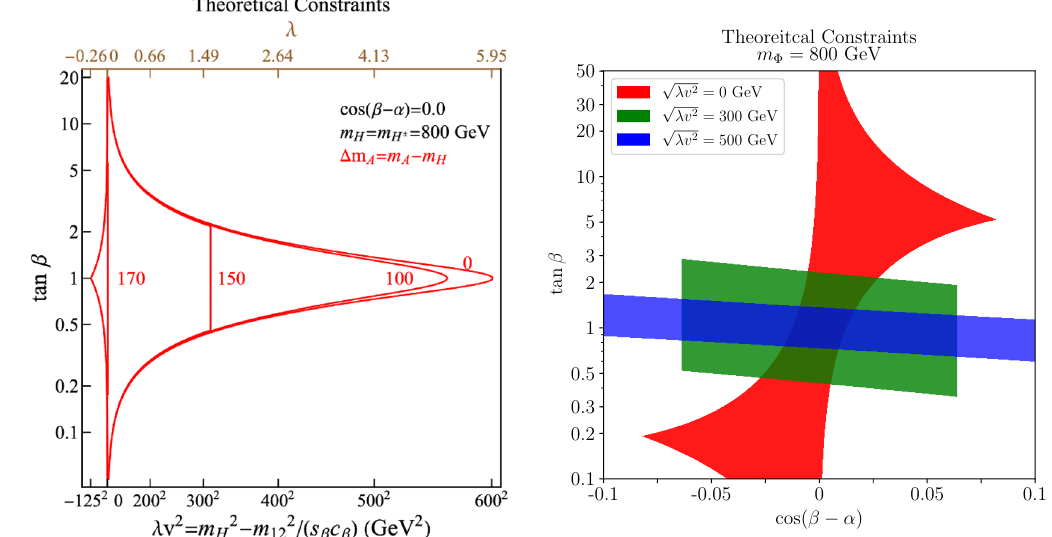
Figure 1 . Left panel: allowed regions in the (cid:21)v 2 taken into account, for m H = m H (cid:6) = 800 GeV, with (cid:12)xed cos( (cid:12) m A m H . Right panel: allowed regions in the cos( (cid:12) (cid:0) varying p (cid:21)v 2 = 0 (red), 300 GeV (green), 500 GeV